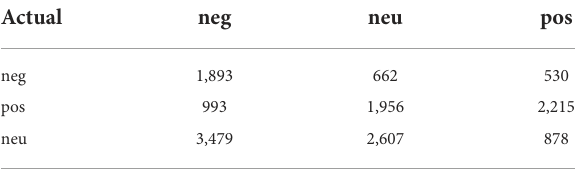
TABLE 1 Subjective and objective online community identification